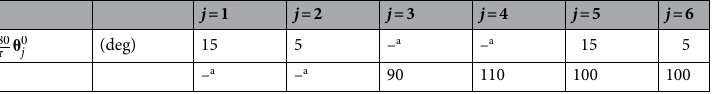
Table 2. Optimal joint angles of each muscle. a Does not affect the muscle length regardless of the value, because the moment arms are set to zero to avoid transforming the